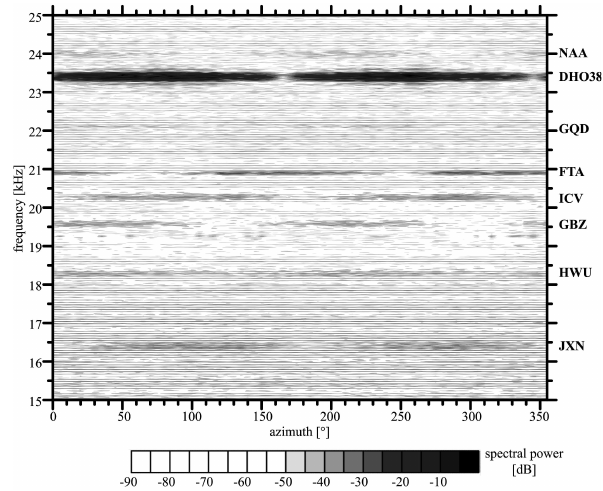
Fig. 12. Normalised logarithmic spectrogram calculated from the power spectra of each azimuthal 5 ◦ increment of the magnetic field measured by the Cerescope antenna that was connected to a sep- arate analogue to digital converter. Signals of eight VLF transmit- ters can be identified by their frequency. Their bearing with respect to the investigation area next to Frankfurt am Main (Germany) are shown by the minimum of the spectral power (cf. Fig. 11): JXN (16.4kHz; distance to measuring location 1892km; bearing 007 ◦ ), GBZ (19.6kHz; distance to measuring location 942km; bearing 308 ◦ ), GQD (22.1kHz; distance to measuring location 910km; bearing 308 ◦ ), DHO38 (23.4kHz; distance to measuring location 322km; bearing 352 ◦ ), FTA (20.9kHz; distance to measuring loca- tion 456km; bearing 248 ◦ ), HWU (18.3kHz; distance to measuring location 652km; bearing 236 ◦ ), ICV (20.27kHz; distance to mea- suring location 1039km; bearing 173 ◦ ), NAA (24.0kHz; distance to measuring location 5488km; bearing 294 ◦ ; 44 ◦ 38 0 N, 67 ◦ 16 0 W;